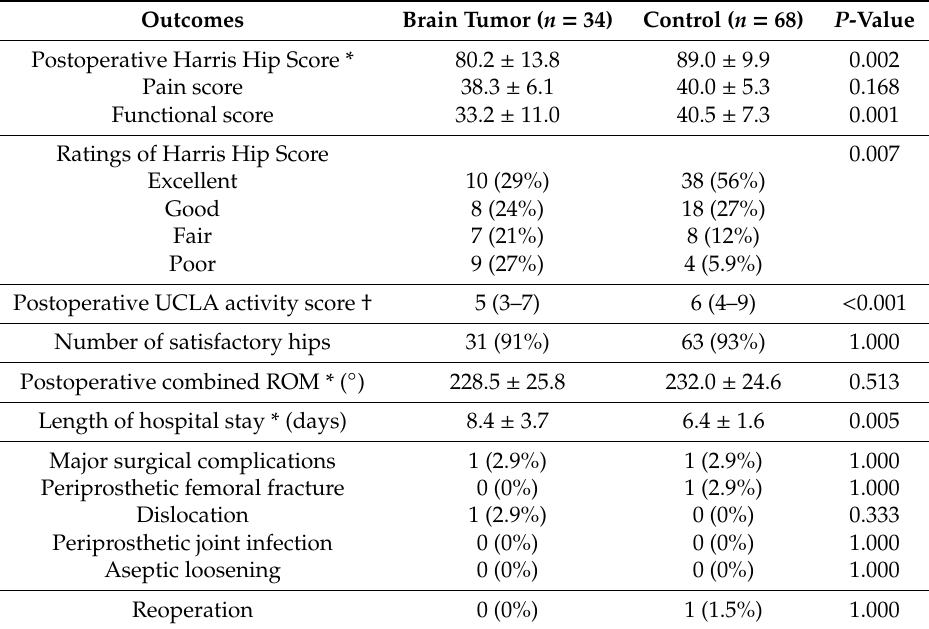
Table 5. Clinical outcomes of